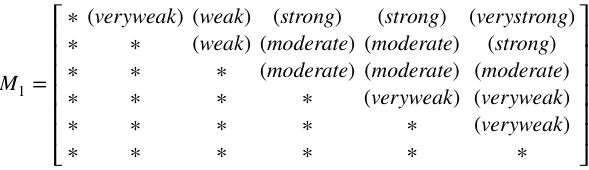
of attractiveness, using triangular fuzzy numbers, generating a fuzzy decision matrix.